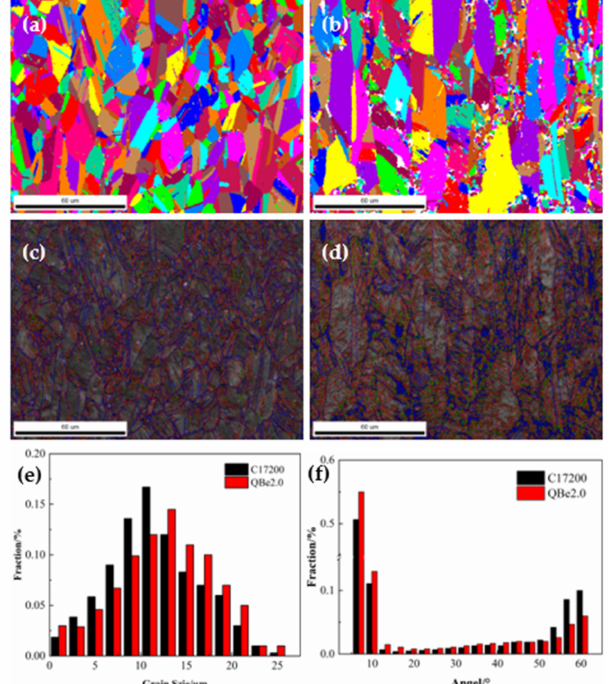
Figure 4. EBSD micrographs and orientation maps of alloys at the peak aging. ( a , c ) C17200; ( b , d ) QBe2.0; ( e ) grain size of the tested alloys; ( f ) misorientation angle distributions of the tested alloys. HAGBs are shown as blue lines, and LAGBs are shown as red